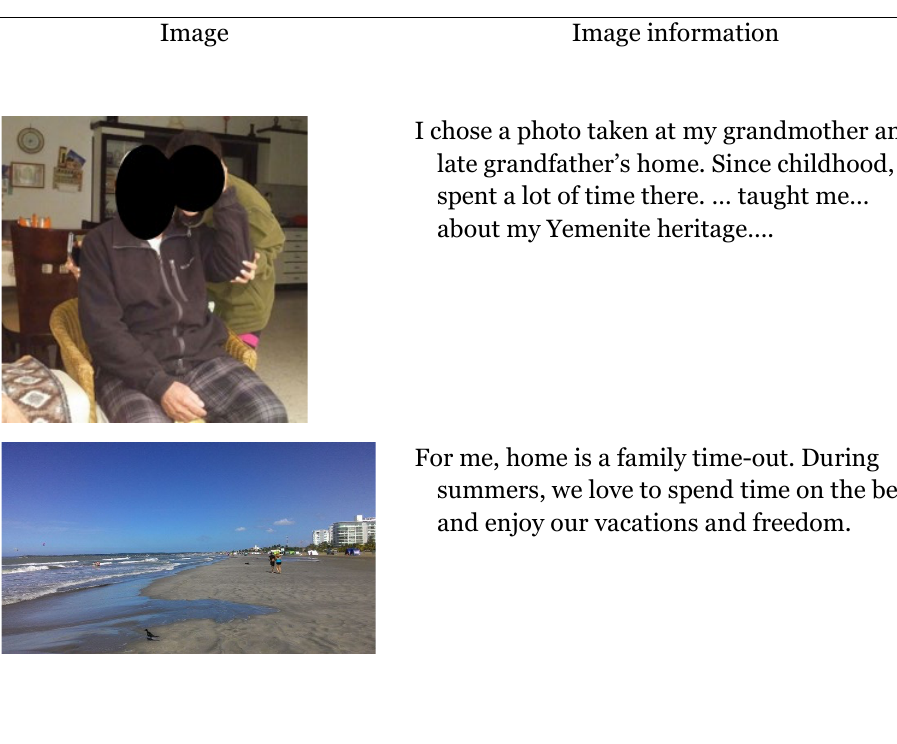
Table 4 Number and Examples of Comments on the Images and Texts Uploaded by TPD Program